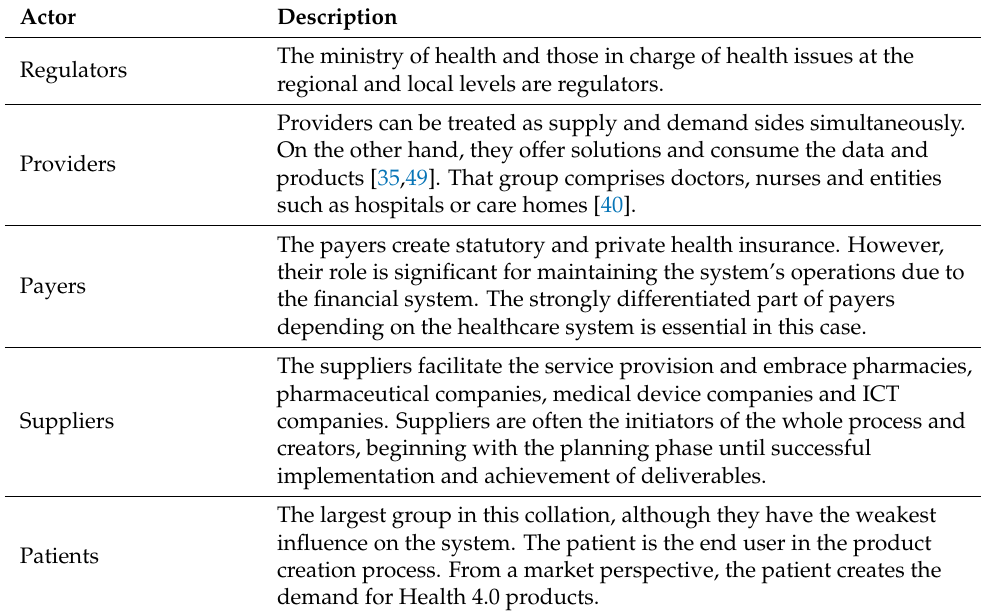
Table 2. Classification of healthcare